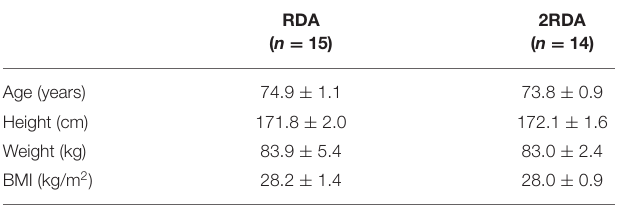
TABLE 1 | Physical characteristics of